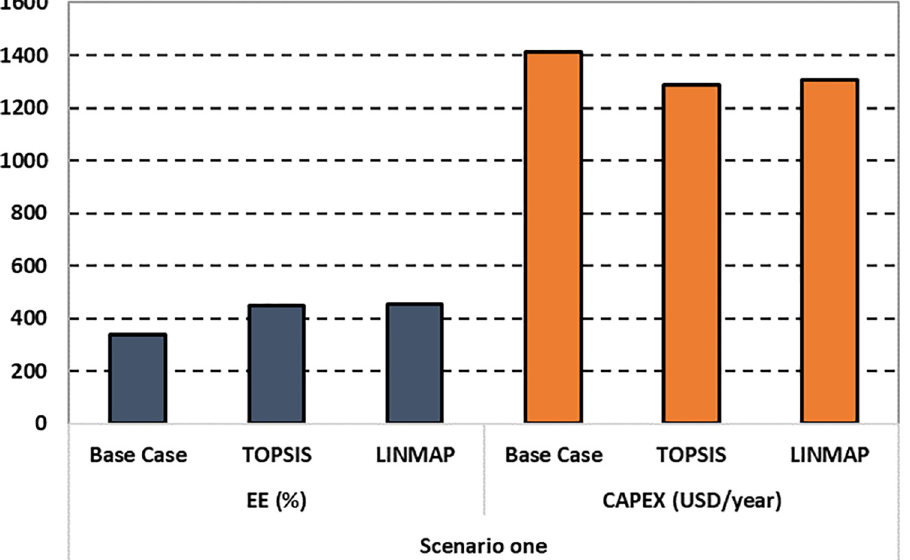
Fig 6. Comparison of EE and CAPEX for the first